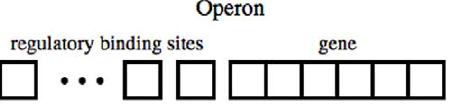
Figure 2. Jacob and Monod operon model for the regulation of protein production. The transcription is regulated by the activators and the repressors binding to the binding sites of the gene.